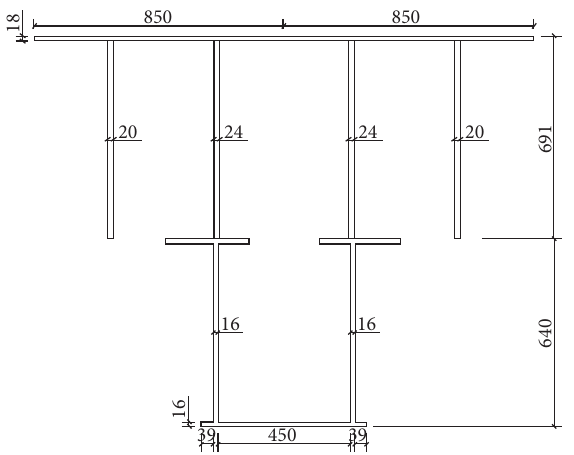
Figure 12: Section diagram of the reinforced longitudinal beam (unit: mm).